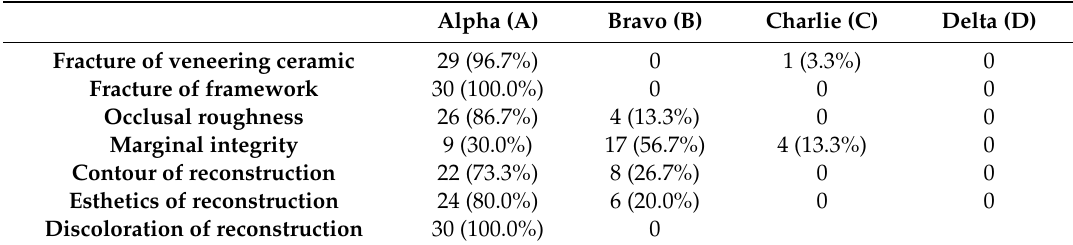
Table 10. Results applying modified USPHS criteria as mentioned in Table 1 at